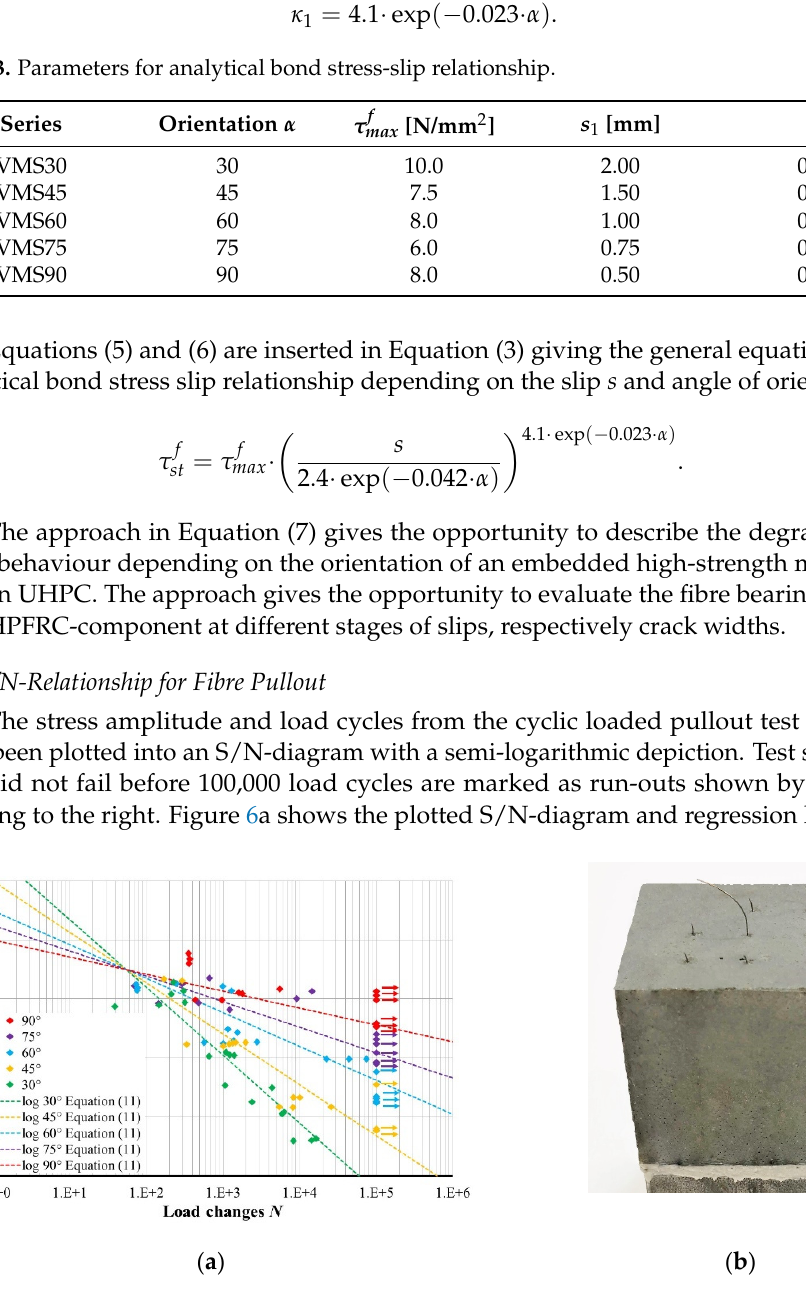
Figure 6. Results of cyclic tensile loaded pullout test: ( a ) S/N-diagram of pullout tests with different orientations and ( b ) photo of a test specimen after cyclic loading with ruptured and pulled-out fi- bres.